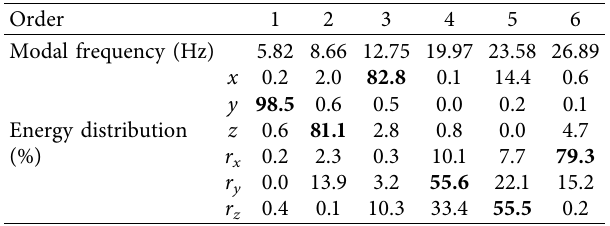
Table 2: Modal frequency and energy distribution of UCE in the original scheme. Order 1